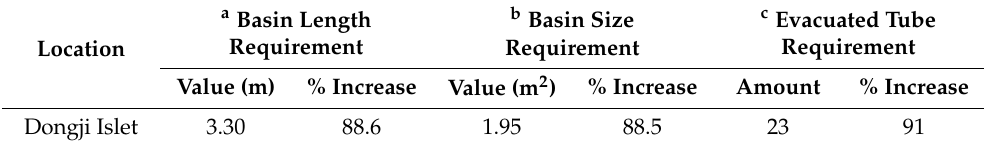
Table 11. Scaled solar still specifications.